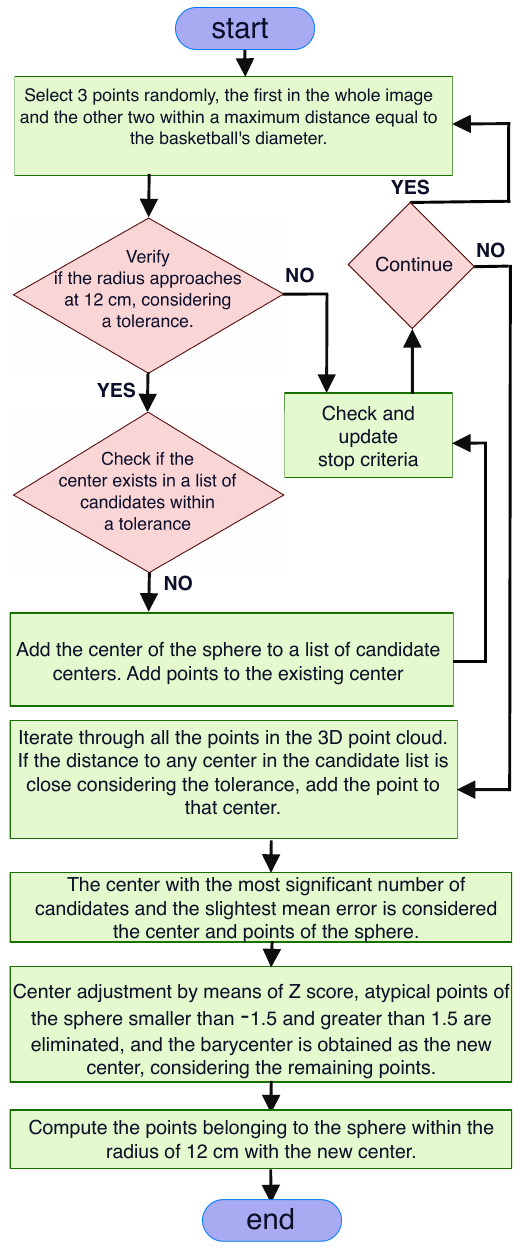
Figure 3. Flow chart of the proposed